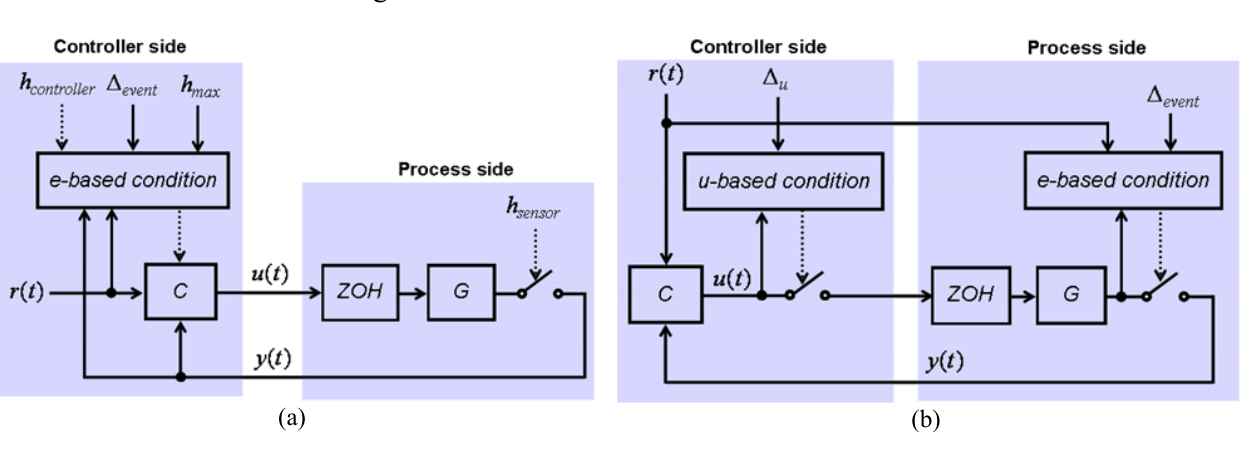
Figure 6. (a) Control scheme of the hybrid strategy. (b) Control scheme of the pure